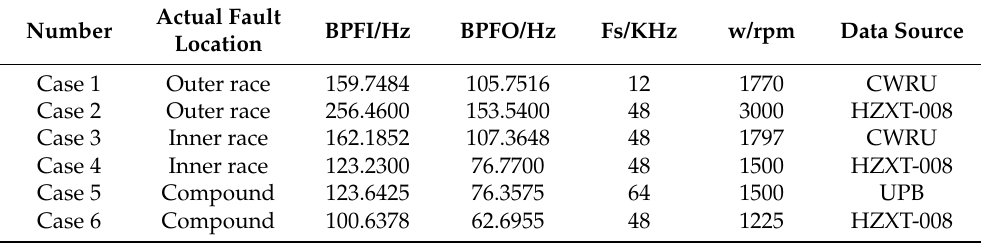
Figure 10. The common fault of rolling bearing: ( a ) outer race crack; ( b ) outer race pitting; ( c ) inner race crack; ( d ) inner race pitting. Table 2. Experimental data statistics.